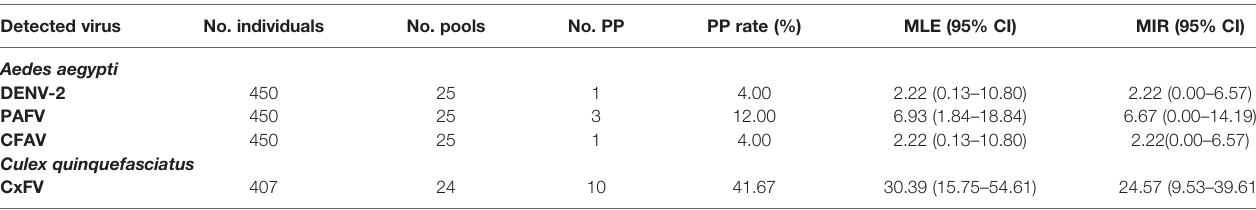
TABLE 2 | Maximum likelihood estimation (MLE) and minimum infection rate (MIR) of fl avivirus in mosquitoes from Jeddah, Saudi Arabia in the fi rst half 2016. Detected virus No.